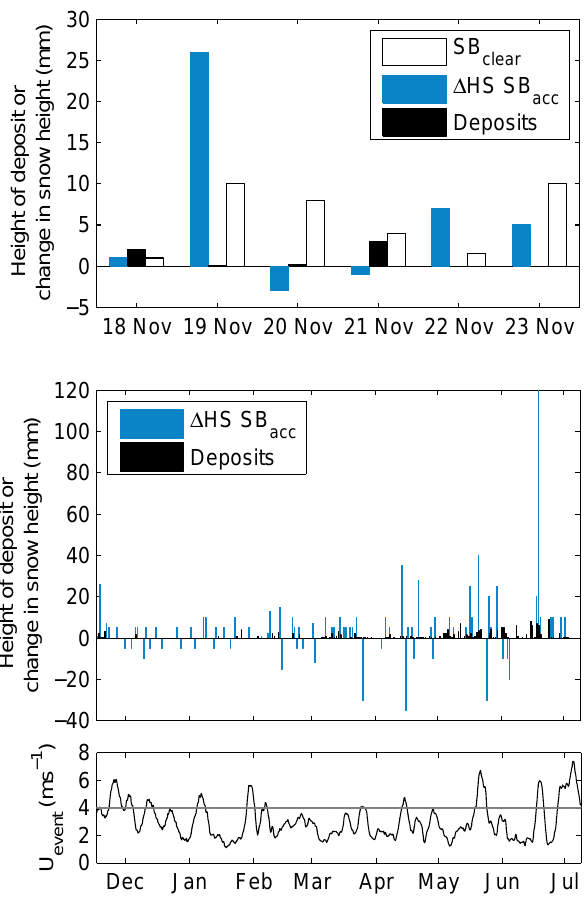
Fig. 4. Height of solid deposits (mm) measured daily either on a table 1m above the surface or at the surface on a daily cleared snow board (SB clear ), and change of snow height 1 HS over an untouched snow board (SB acc ). Top: 18–23 November 2008; mid- dle: 18 November 2008–July 2009, board SB clear not shown. Bot- tom: 100-h moving average wind speed ( U event ,ms − 1 ) in black, 18 November 2008–July 2009. The grey line represents the mini- mum wind speed (4ms − 1 ) necessary for an event (see Sect.